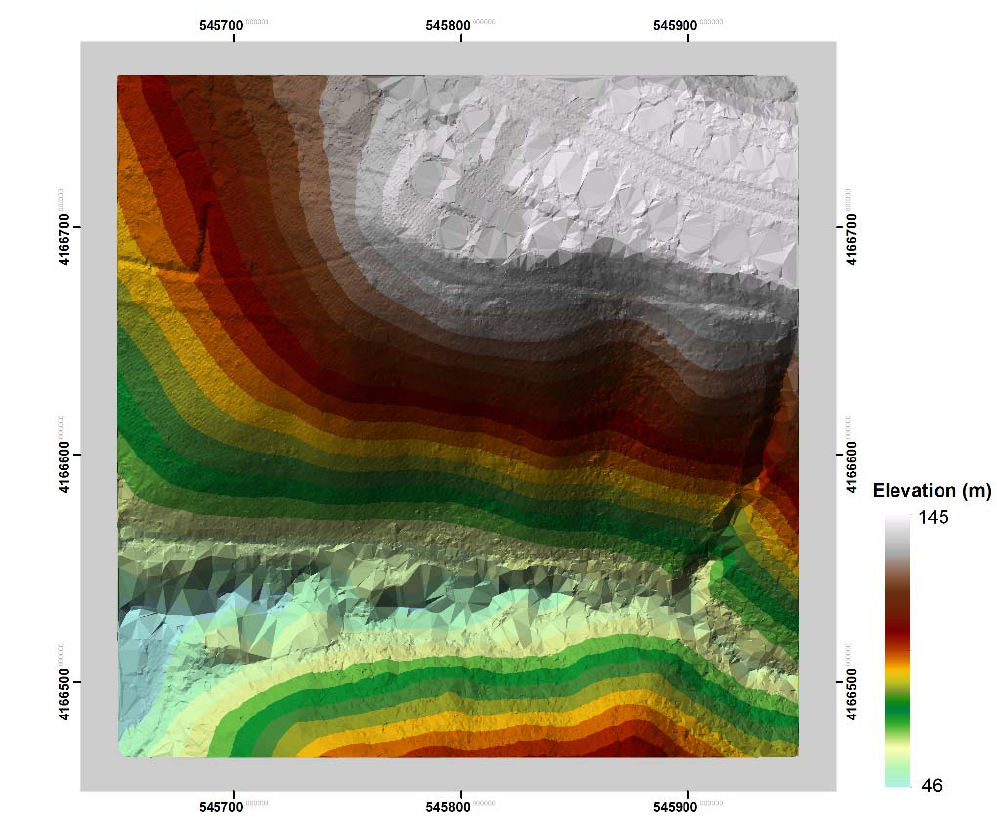
Figure 4. An elevation map of the study area, which is located in UTM zone